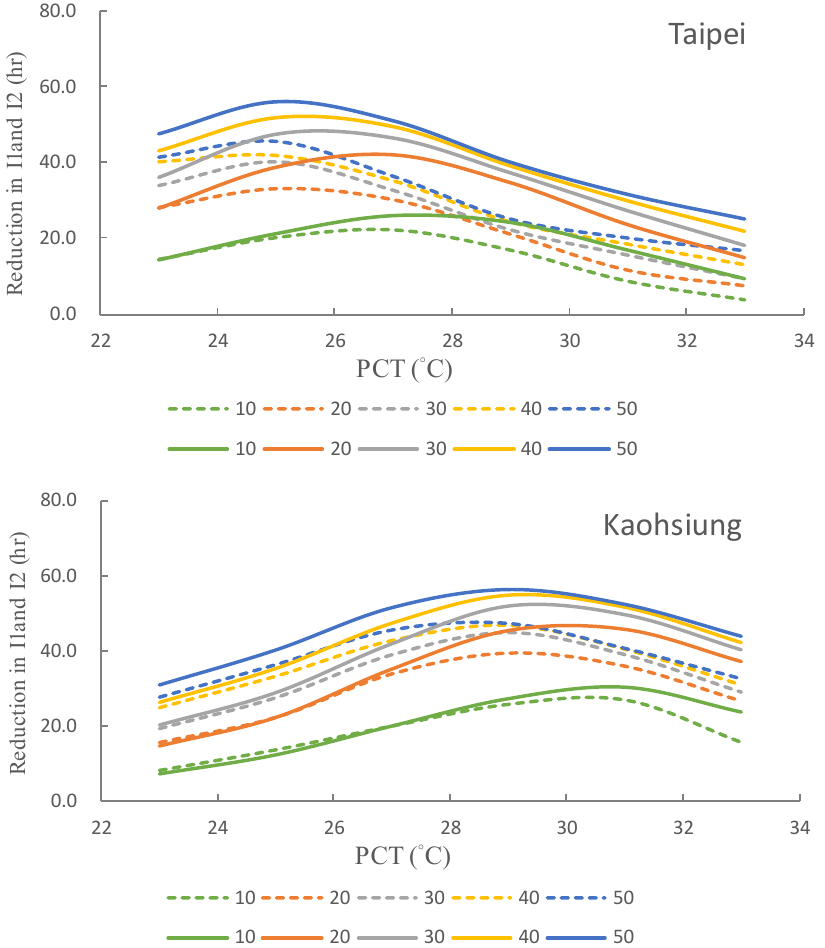
Figure 7. Effects on thermal comfort of different thicknesses of PCM roofs during the ventilation season from November to April.